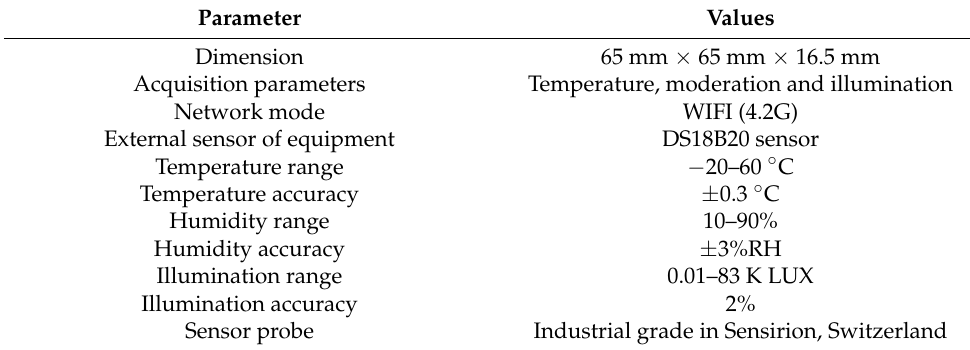
Figure 10. Sensor positions; drawn by the authors. Table 9. Sensor